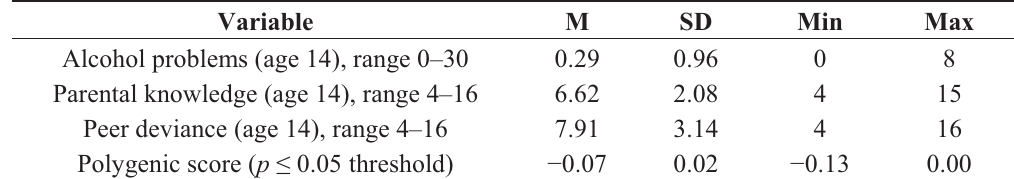
Table 2. FinnTwin12 descriptive statistics for focal study